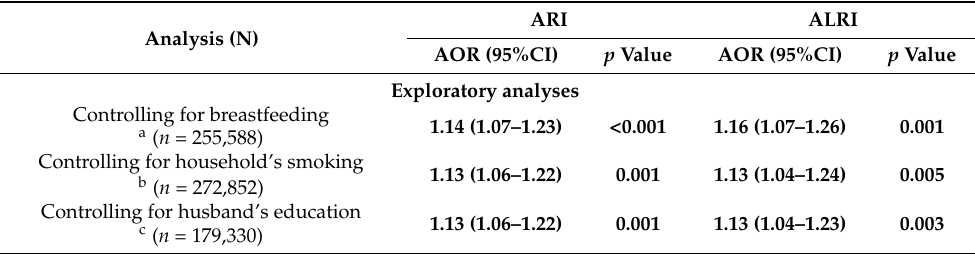
Table A2. Adjusted odds ratio (AOR) with 95% CI of the exploratory analyses for the association of ARI and ALRI in children aged under five years with biomass cooking compared to cleaner cooking.